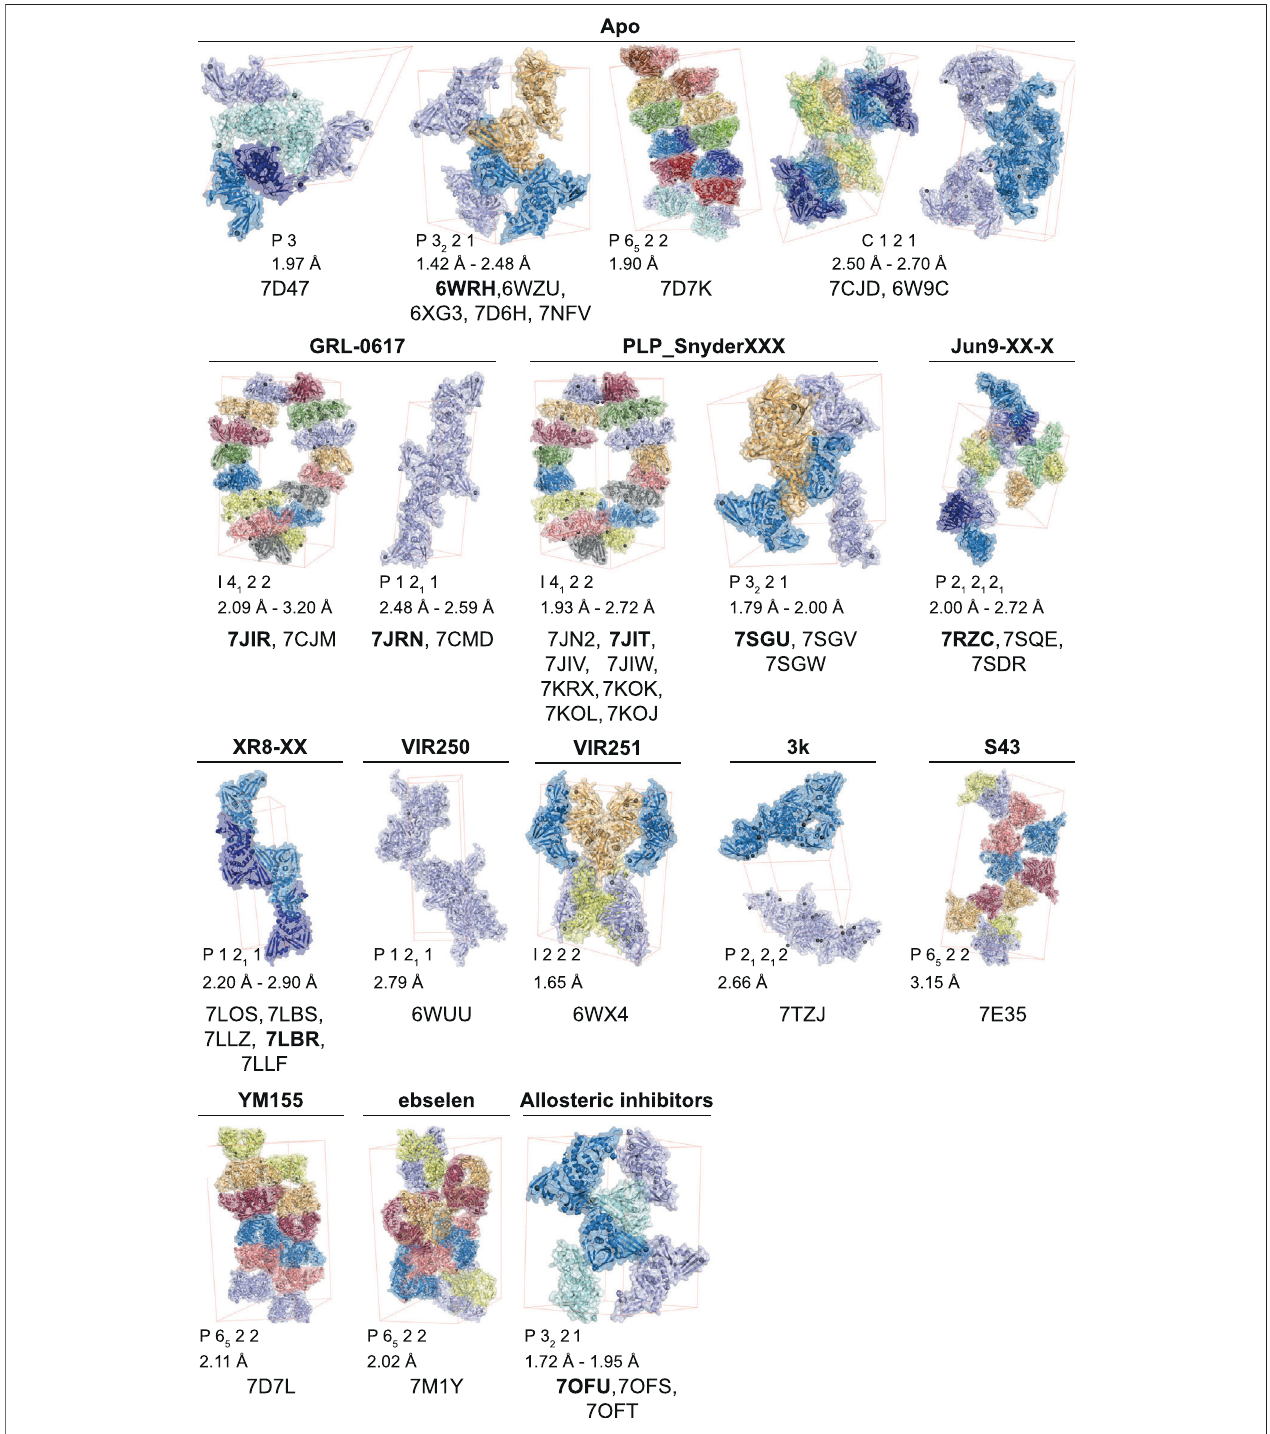
FIGURE 1 | Reported apo and compound structures of SARS-CoV-2 PLpro. Shown are unliganded and compound bound structures publicly released in the Protein Data Bank (PDB) since the beginning of the COVID-19 pandemic. The unit cell for each space group is shown (thin red lines) and the corresponding symmetry mates from the asymmetric unit are depicted with matching colours. The structures are grouped according to their bound ligands, the ligand is labelled above each unit cell, and the corresponding PDB accession numbers shown below. The obtained resolution or resolution range for each crystallographic setting is